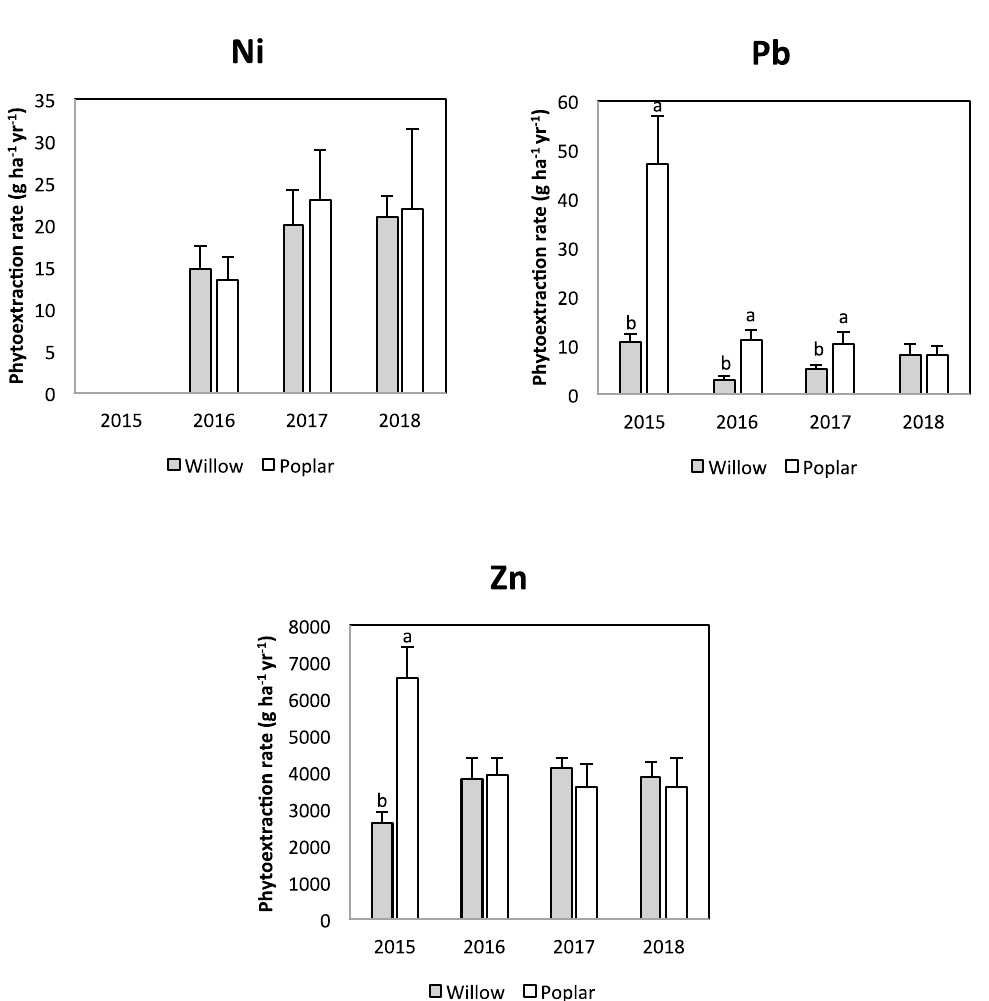
Figure 2. Phytoextraction rates for Cd, Cu, Ni, Pb and Zn of willow and poplar for different years. Data are mean phytoextraction rate values (g ha − 1 year − 1 ) ± SD (n = 12) for each species for each growing season, with the exception of Cd and Ni, which were not detected during the first year. Comparisons were made between species for each year. A 5% significance level was adopted for identifying significant treatment effects according to Tukey’s HSD test.